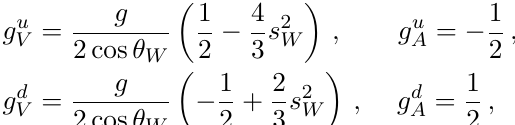
Figure 3 . Ω DM h 2 as a function of m χ h 3 = 0 . 3 are fixed, and h 1 L lines, respectively. In both plots, m 0 = [500 , 1000] GeV is used, and the observed Ω DM h 2 with 5 σ errors is